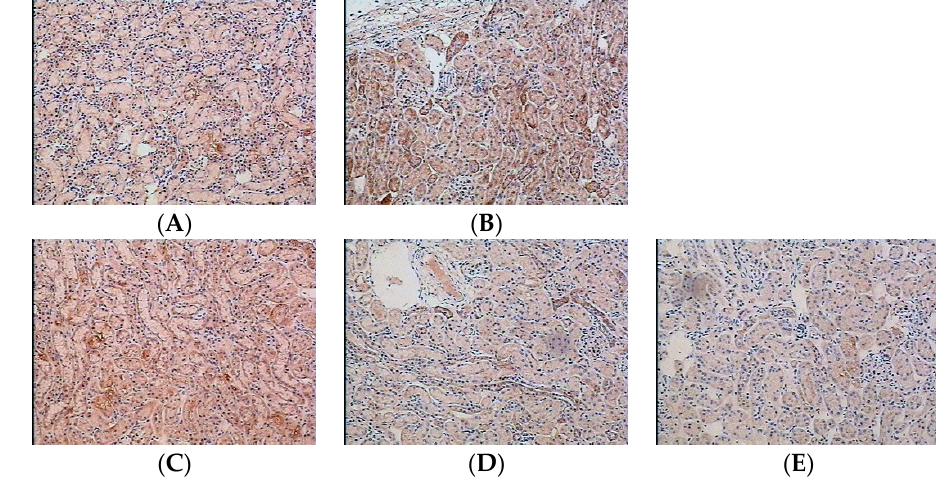
Figure 2. Effects of H. diffusa extract on the infiltration of macrophage in the kidneys: CD68 positive cells stained with immunohistochemistry are shown after treatment with ( A ) saline; ( B ) LPS; ( C ) low dose, 1.25 g/kg bw; ( D ) medium dose, 2.5 g/kg bw; and ( E ) high dose, 5.0 g/kg bw) (magnification is 200×).